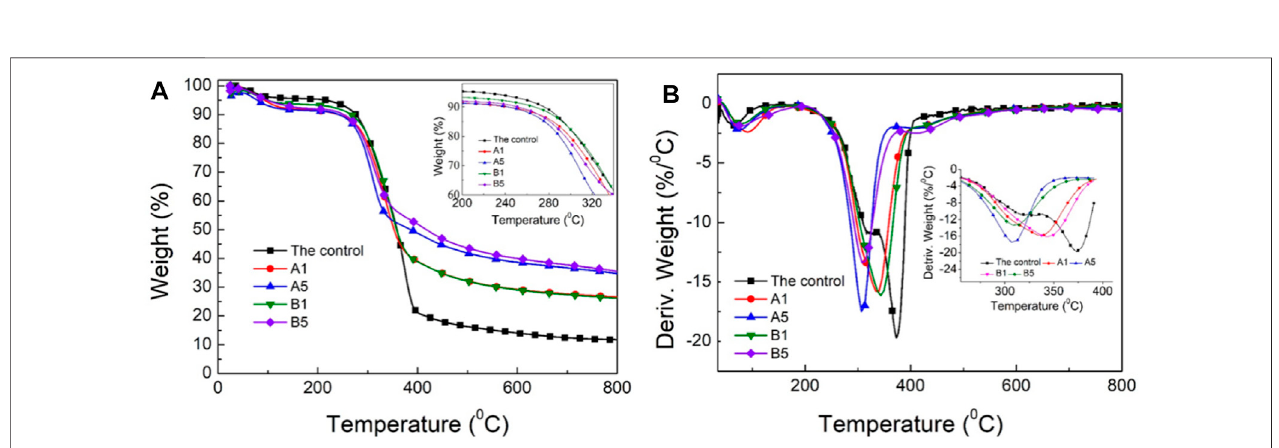
FIGURE 3 | FTIR curves of bamboo specimens: (A) . bamboo specimens before and after self-assembly with PA-PEI; (B) . bamboo specimens before and after treatment with PA solution and PEI solution.